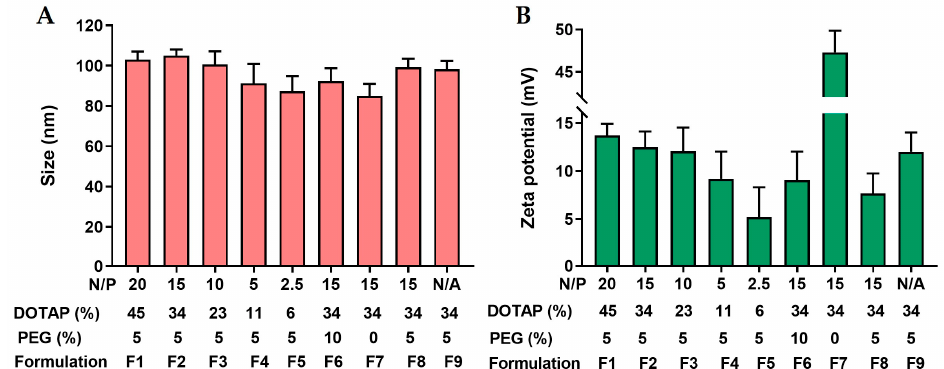
Figure 3. Physical characterization of liposomal ADU-S100 formulations with varying levels of DOTAP and PEGylation. The average hydrodynamic diameter ( A ) and zeta potential ( B ) of the liposomal ADU-S100 were determined using Nano Zetasizer. Data are shown as the mean ± SD ( n ≥ 3) and are representative of three independent formulation preparations.